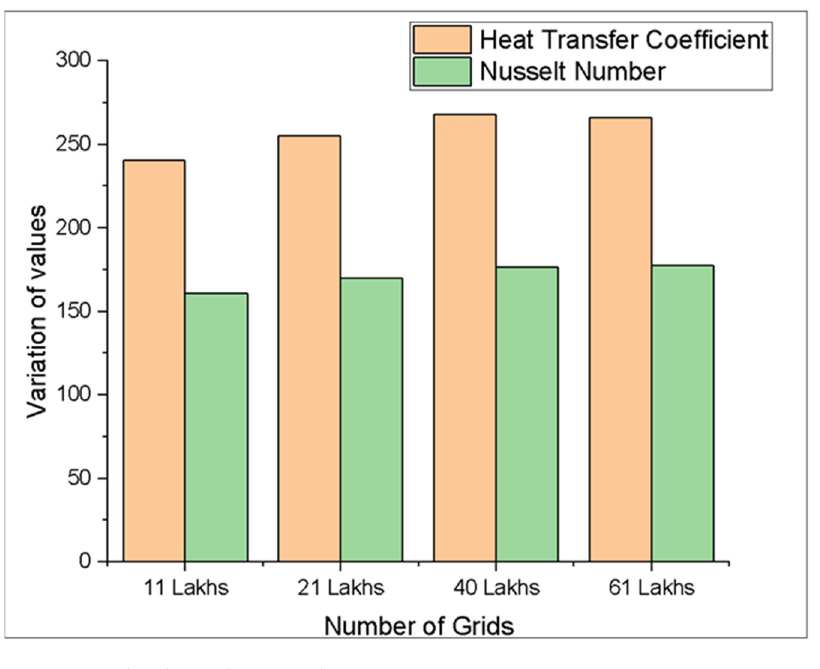
Figure 5. Grid independence analysis.